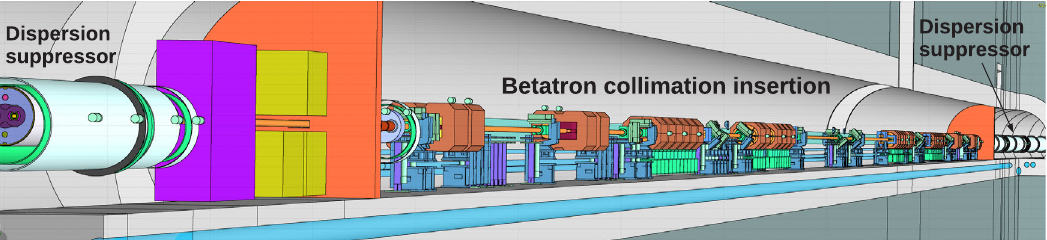
FIG. 8. Geometry model of the LHC betatron cleaning insertion and the first superconducting magnets in the dispersion